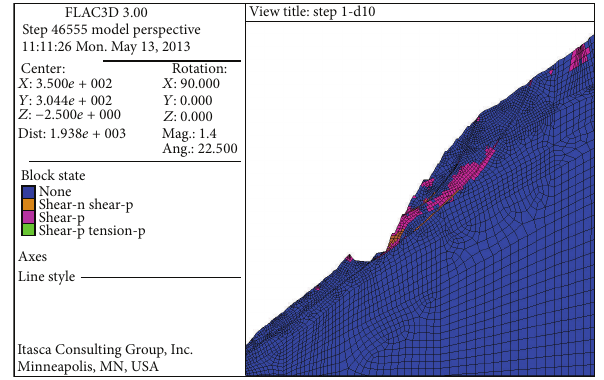
Figure 13: Failure state of the slope